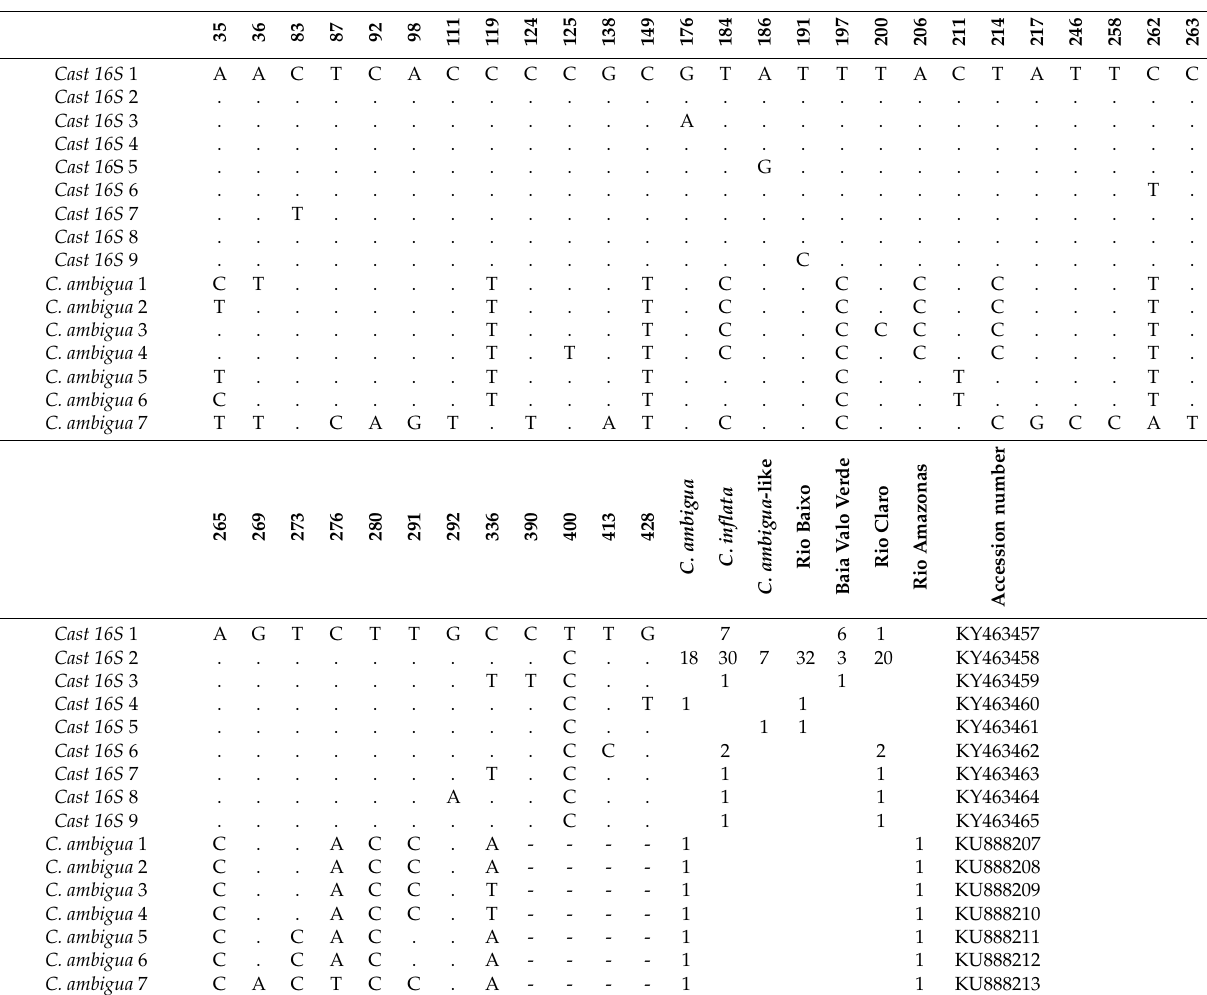
Table 6. Haplotypes for Castalia species at the mitochondrial 16S rRNA gene. Haplotypes Cast_16S _01 through 9 are original data for samples from the upper Paraguay River basin; C. ambigua 1 through 7 are from samples from the upper Amazon River basin [20]. Numbers refer to nucleotide